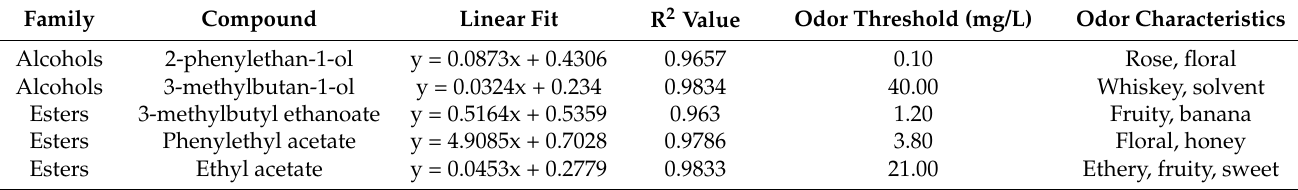
Table 1. Calibration curve of volatile compounds absolutely quantified with their linear fit, R 2 value, odor threshold and odor characteristics, an used for the quantification of fermenting worth and conditioned